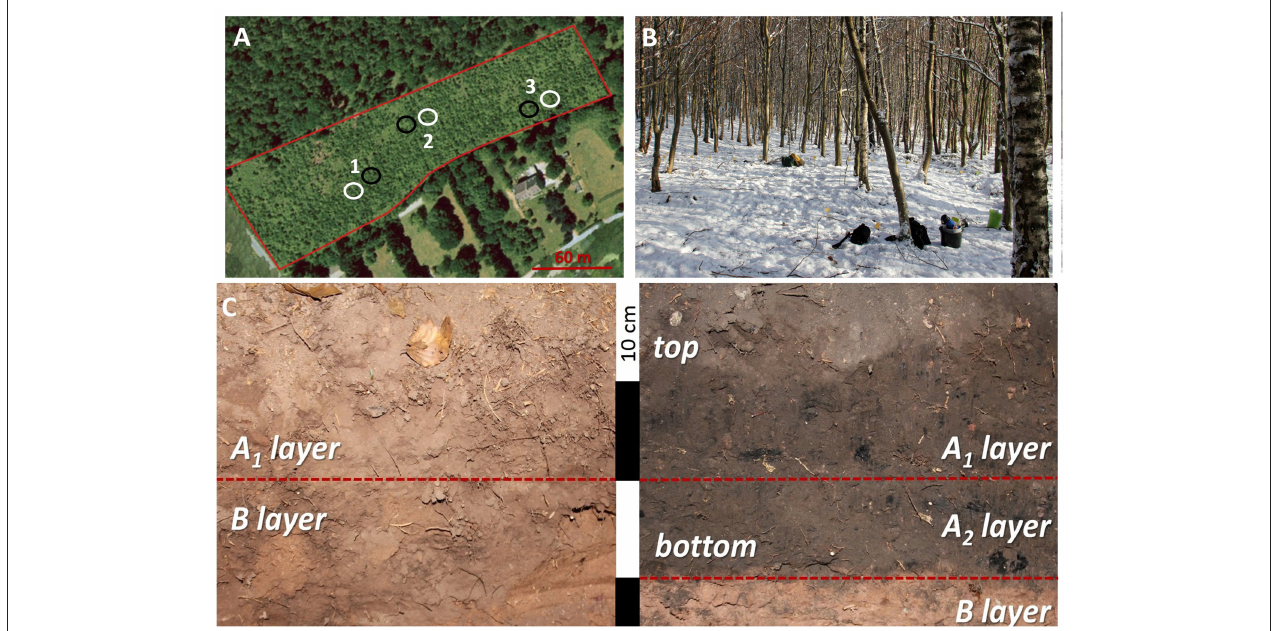
FIGURE 1 | The study area at Regniessart, in Southern Belgium. (A) The investigated parcel how it looked at the beginning of the plantation. Black circles represent the relic charcoal hearth (RCHs) investigated and the relative reference plots. (B) The forest plantation how it looked in January 2017 during the soil sampling campaign. (C) The soil profiles from one RCH (on the right) and the relative reference plot (on the left). The layers in which the soils were divided are marked: in the reference soil the topsoil (A 1 layer) and the subsoil (B layer). In the charcoal hearth soil the top and the bottom part of the charcoal-enriched layer (A 1 and A 2 layer, respectively) and the subsoil (B layer). The so defined soil layers do not coincide necessarily with soil